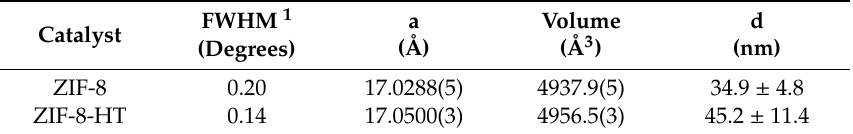
Figure 1. XRD patterns of ( A ) simulated reference ZIF-8 MOF spectra (yellow), measure ZIF-8 (blue) and measured ZIF-8-HT (red). Fitting of the XRD patterns of ( B ) ZIF-8 and ( C ) ZIF-8-HT. The blue and red lines are the fitted profile for ZIF-8 and ZIF8-HT, respectively. The black circles are the observed data, and the gray line is the difference in the two patterns. The ticks represent positions of allowed Bragg peaks for ZIF-8 MOF. Table 1. Crystallographic parameters obtained by powder XRD